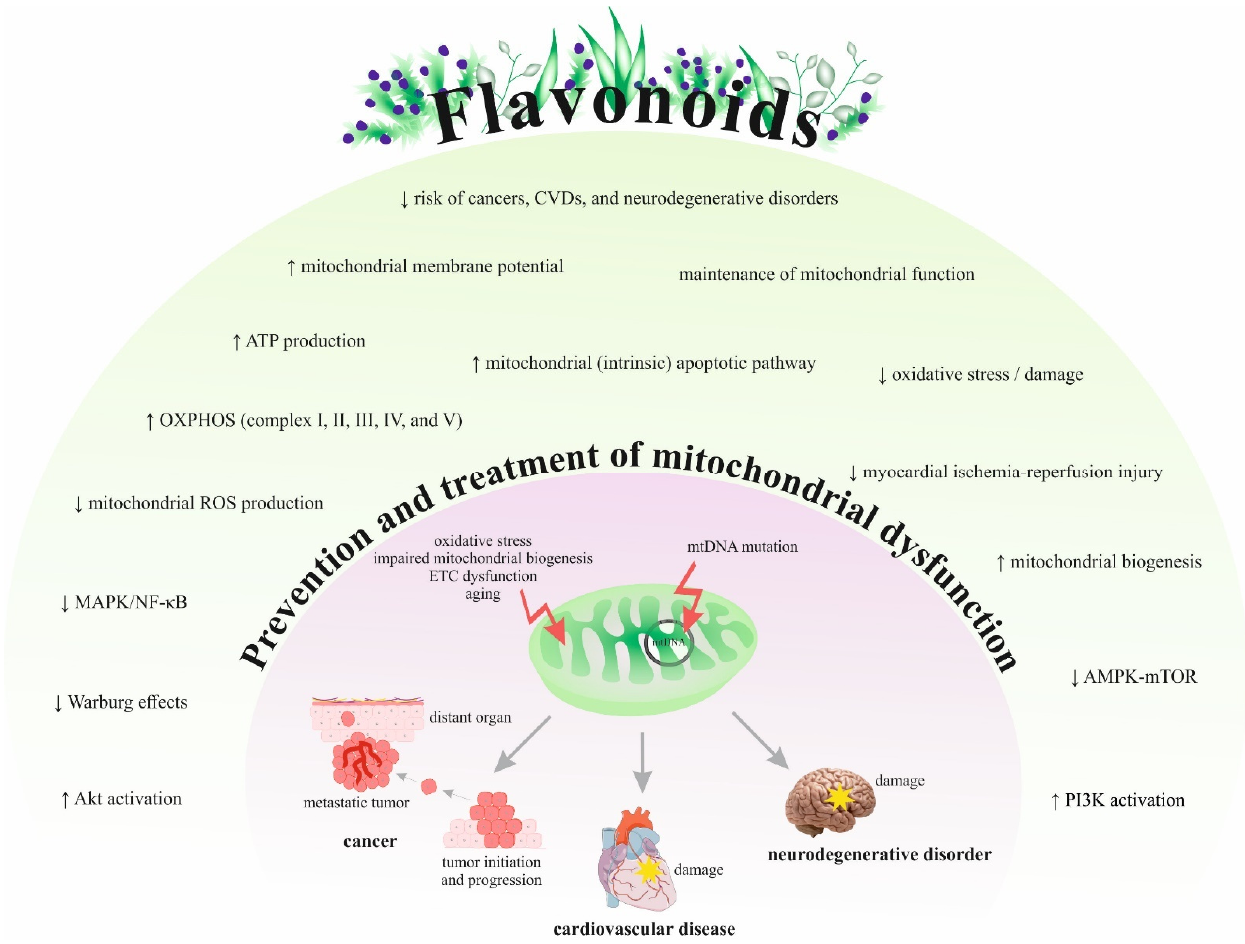
Figure 3. The mechanisms of flavonoids in the prevention and treatment of mitochondriopathies. Abbreviations: EGCG, Figure 2. Chemical structures and key representatives of the six major flavonoid epigallocatechin-3-gallate; EGb 761 ® , Ginkgo biloba extract; CVDs, cardiovascular diseases; mtDNA, mitochondrial DNA; OXPHOS, oxidative phosphorylation; ROS, reactive oxygen species; ↑ , increase/induce; ↓ , decrease/reduce; ETC, electron transport chain.